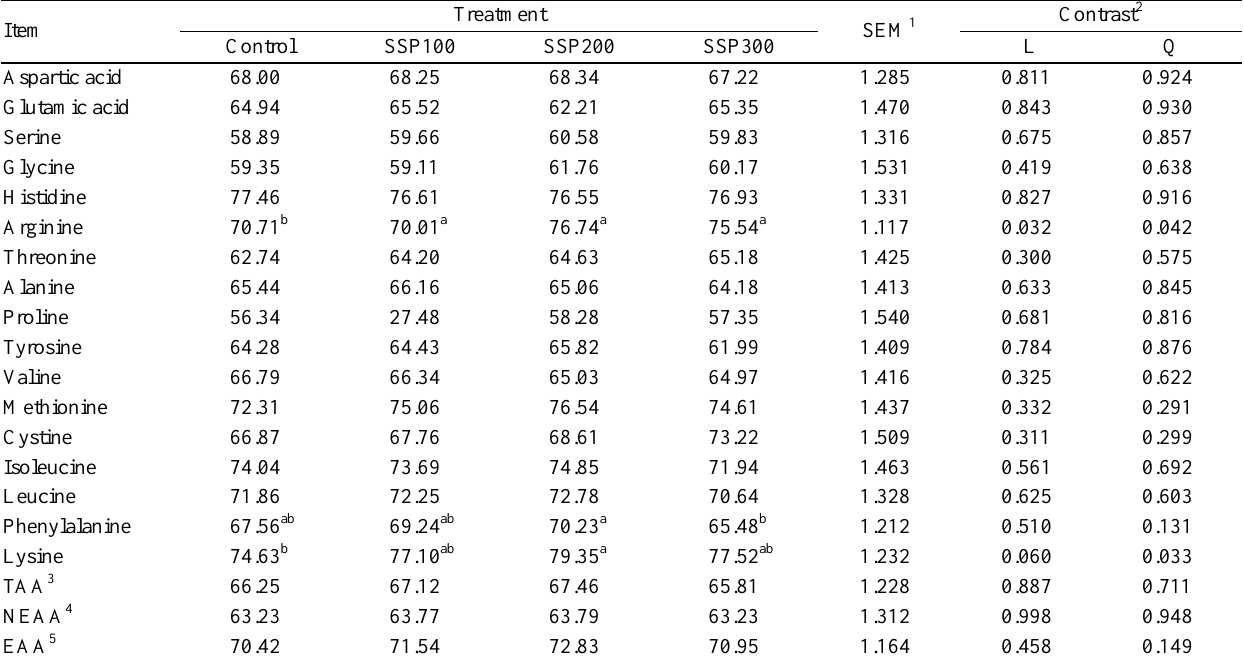
1 SEM = Standard error of mean. 2 p values for the linear (L) or quadratic (Q) effects of SSP infused at the rates 0, 100, 200, 300 g·cattle -1 ·d -1 . 3 TAA = Total amino acids. 4 NEAA = Non-essential amino acids. 5 EAA = Essential amino acids. a-b Means within a row with different superscript letter differ